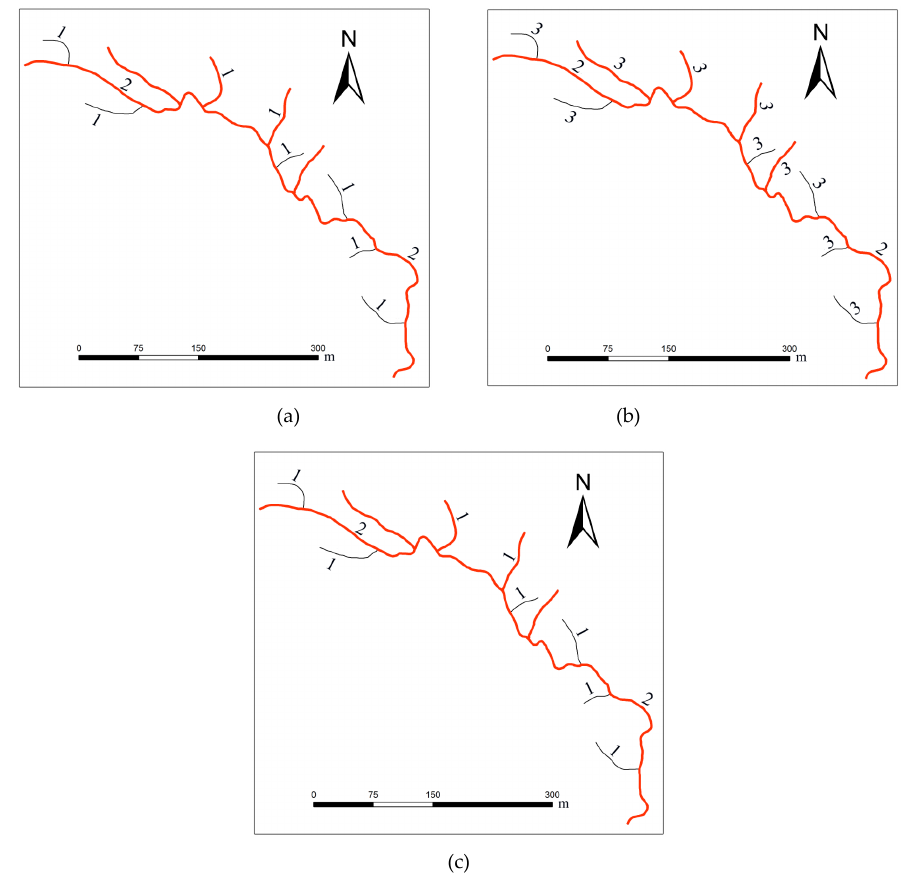
Figure 10. Comparison of the selections in a modest branch: ( a ) selection result based on the top-down coding method, ( b ) selection result based on the bottom-up coding method and ( c ) selection result based on the hybrid coding method (the selection results are shown as red lines, and the original rivers are shown as black lines).